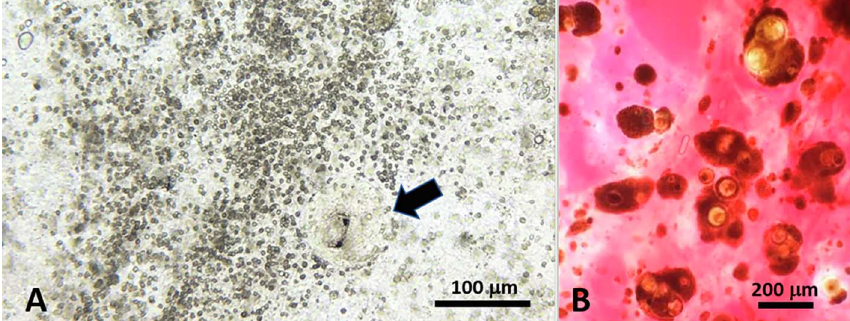
Figure 5. Unidenti fi ed metacercariae from Coptodon guineensis at Sebkha Imlili. A. Metacercaria (arrow) showing ocelli and associated with intense granulocytic reaction in intestinal mucosa. B. Fresh squash of spleen showing numerous